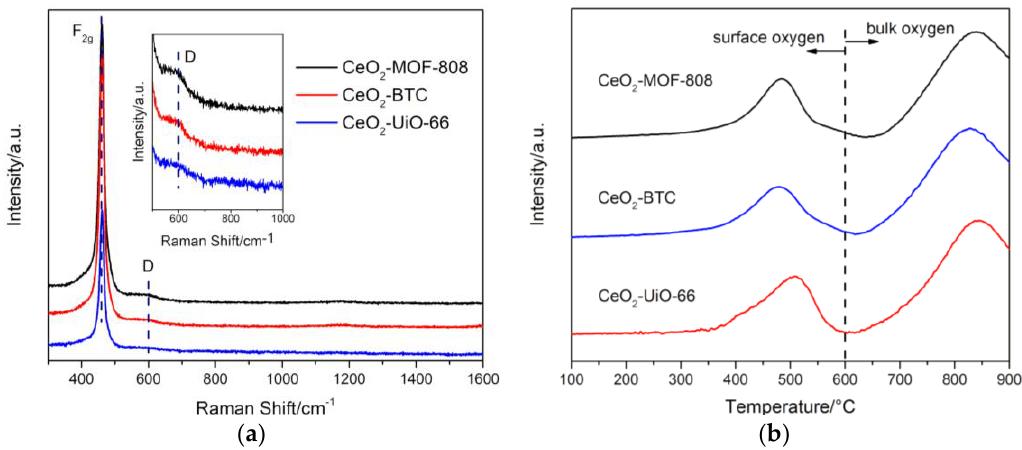
Figure 6. ( a ) The Raman curves of CeO 2 -MOFs and ( b ) the H 2 -TPR of CeO 2 -MOFs.